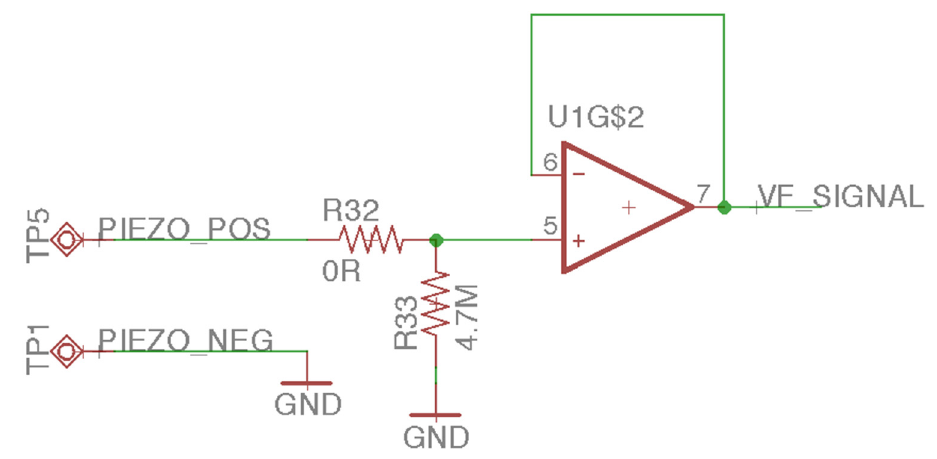
Figure 11. The voltage follower of the laser audio signal receiver circuit.